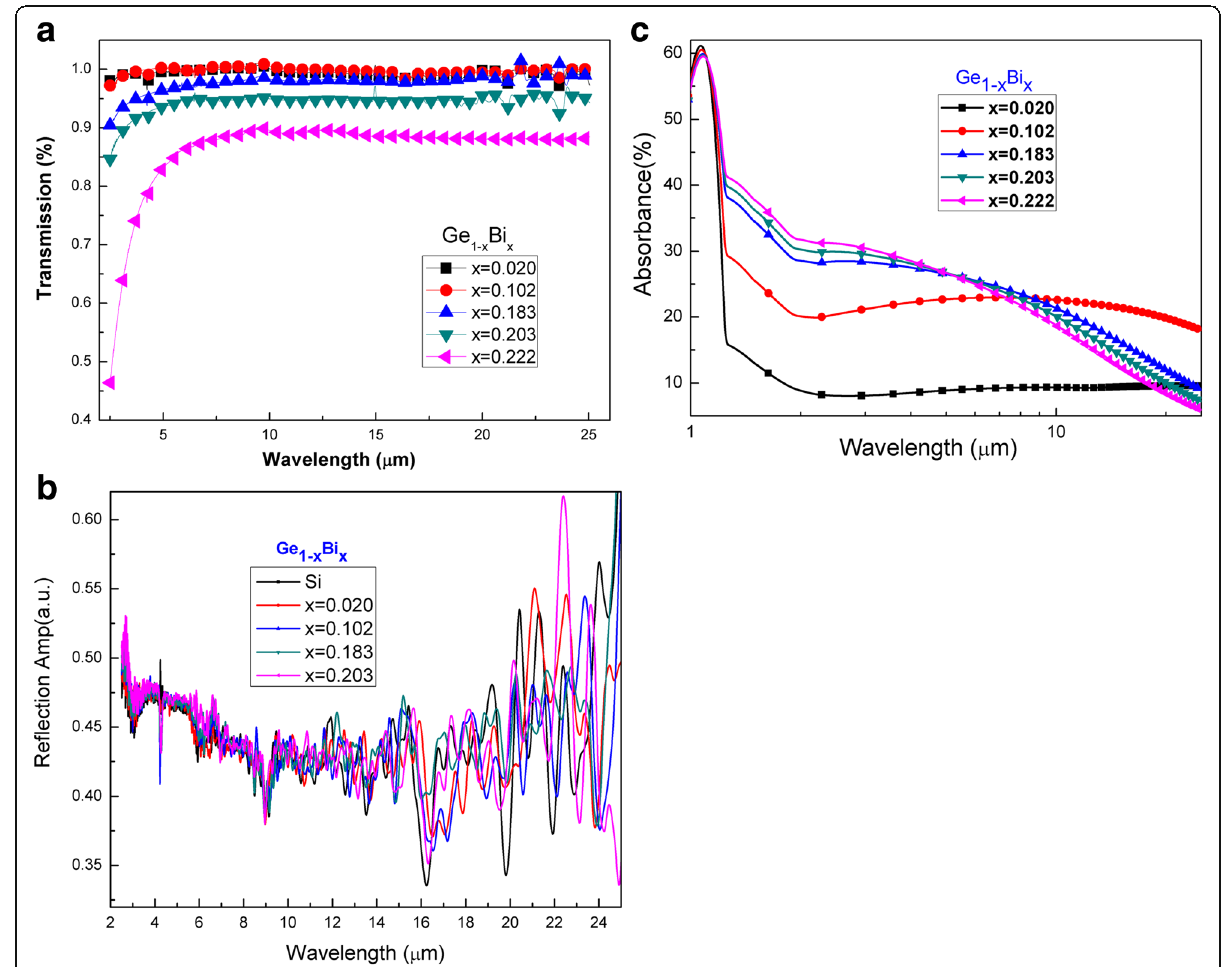
Fig. 6 Transmission spectra ( a ), reflectance spectra ( b ), and absorption spectra ( c ) of GeBi films with different Bi contents in far-infrared wave